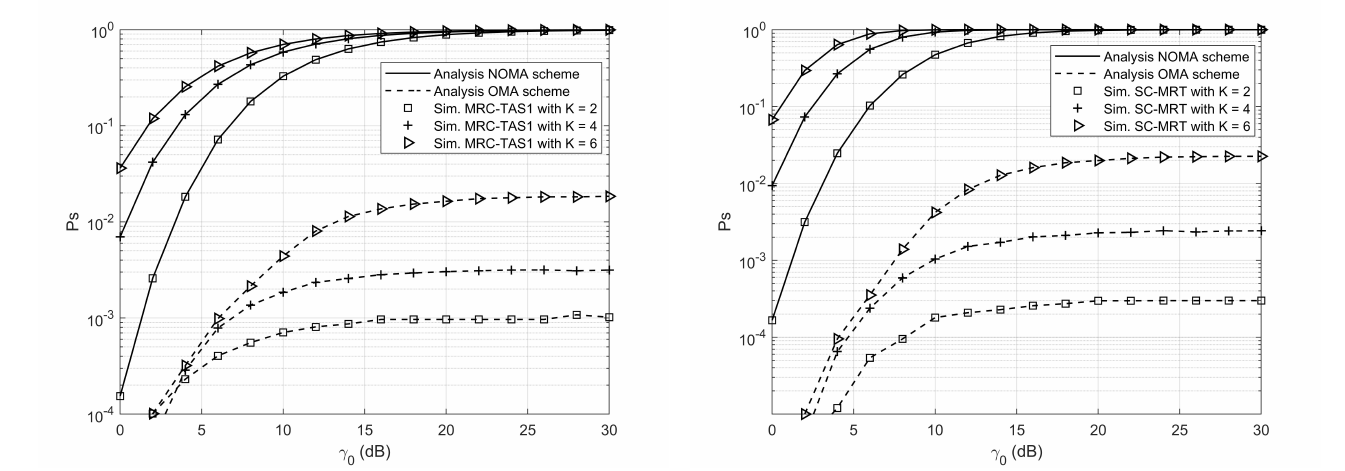
Figure 7. Impacts of the number of antennas K on Ps of SC-MRT scheme